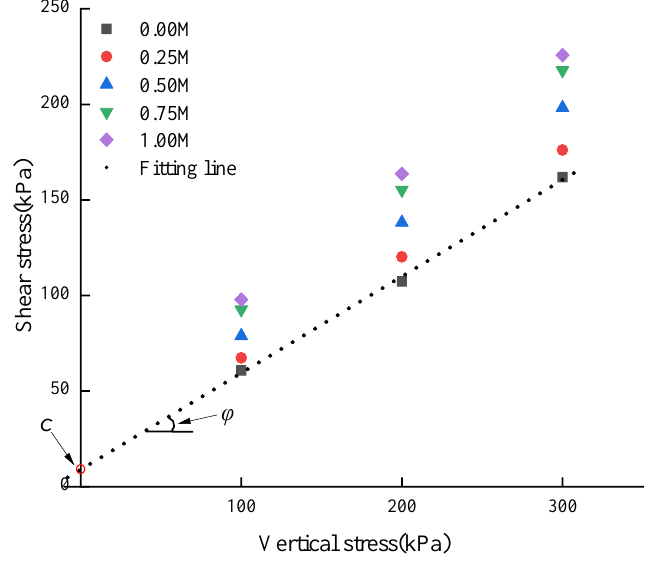
Figure 5. Shear stress variation with vertical stress. Table 3. Mechanical parameters of shear